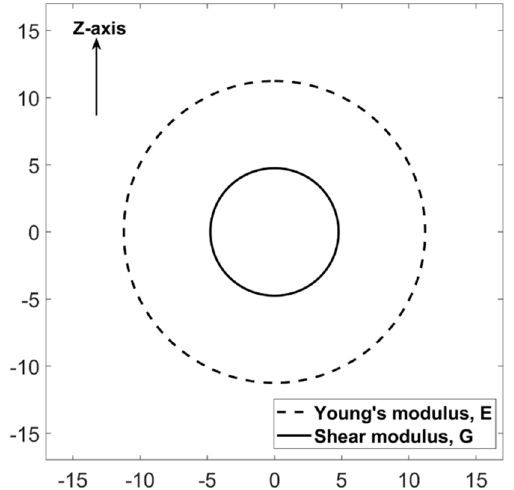
Figure 13. Polar plots of Young’s (E) and shear (G) moduli of empty sH gas hydrate at 0 K and − 1 GPa pressure. Moduli unit is GPa.